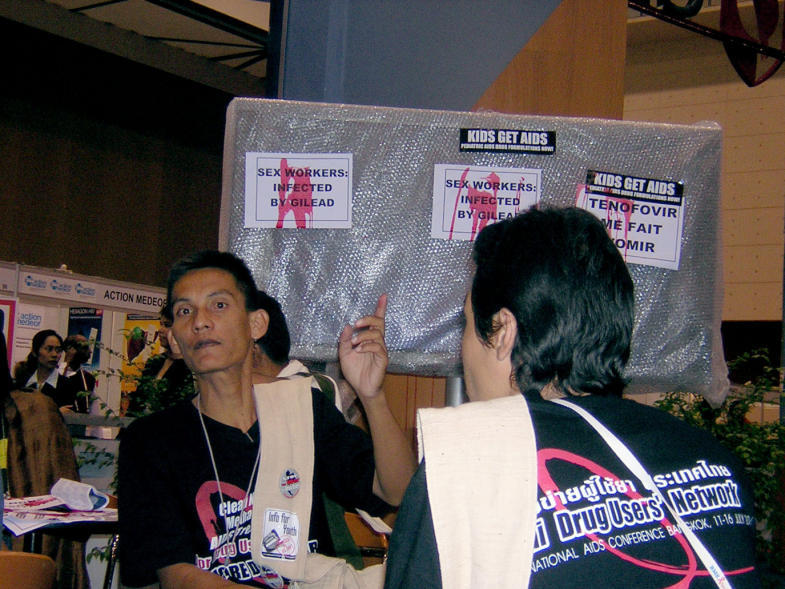
The Dramatic Protest at the Gilead Booth at the International AIDS Conference 2004 Caught the World's Attention(Photo: Act Up–Paris)